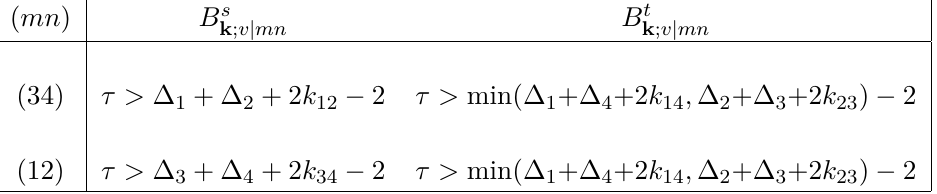
functional’s integrand. In the equal operator limit, the s - Table 1 . Collinear limit of the B s,t k ; v | mn and t -channel conditions become